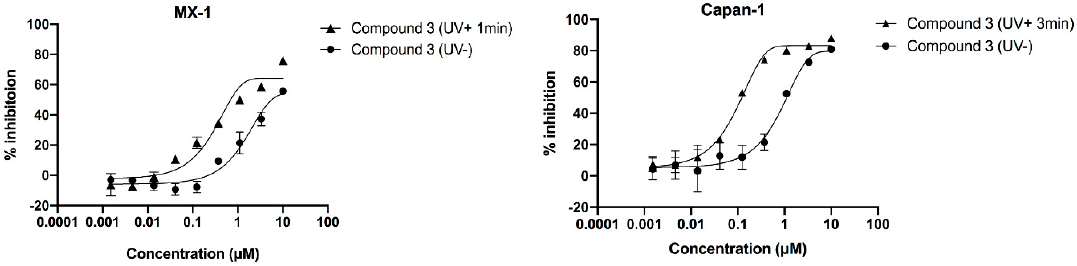
Figure 5. Dose–response curves of compound 3 in the absence and presence of ultraviolet irradiation. Cells were incubated for 1 h with the compounds and were then irradiated at 365 nm (4.1 mW/cm 2 ). Cell growth was determined 10 days after incubation with the compounds. Irradiated compounds showed left-shifted dose–response curve compared to that of the unirradiated compounds. Error bars represent the standard deviation from duplicate determinations, and results are shown as mean ± SD. The IC 50 value is presented in Table